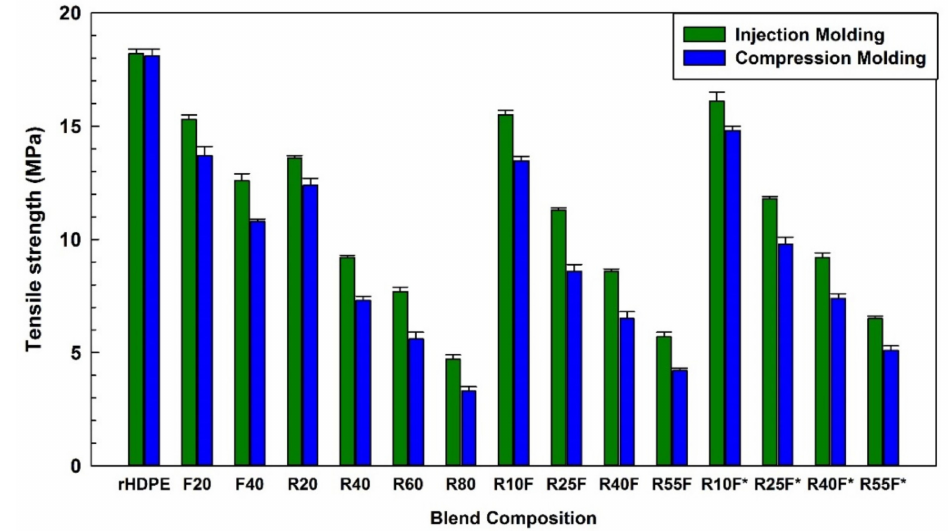
Figure 5. Tensile strength of the composites (see Table 1 for